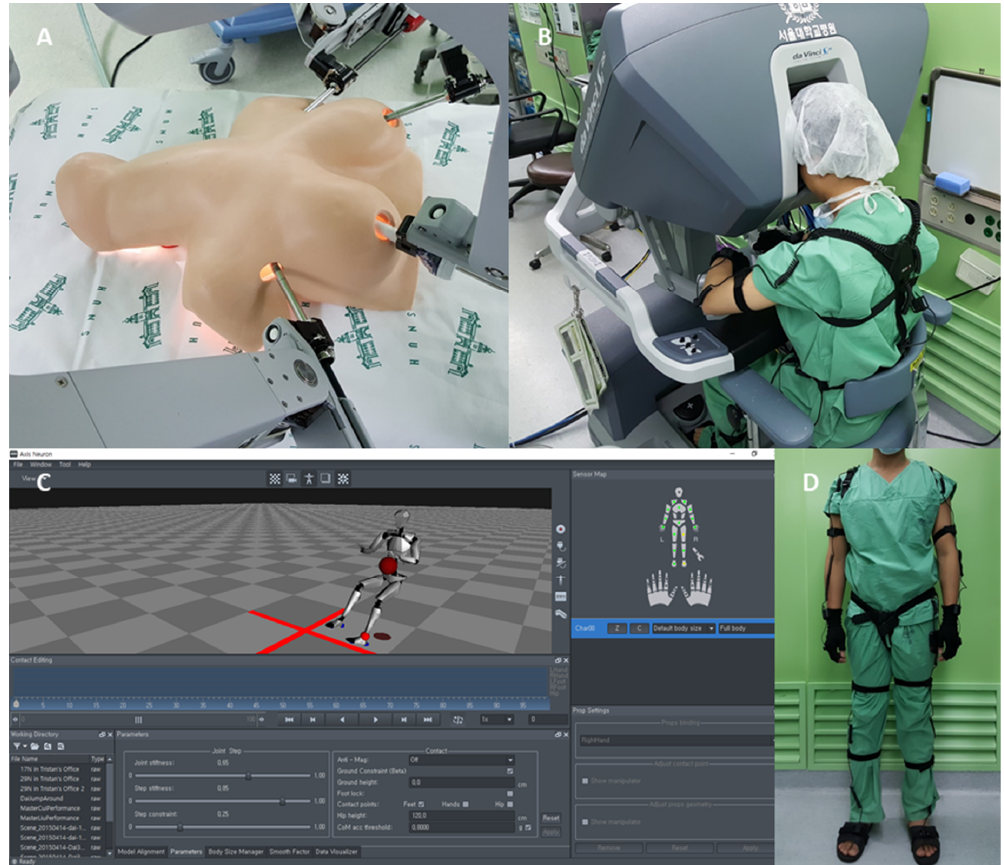
Figure 2. Materials used to study the usefulness of a motion capture device in surgical training. ( A ) Photograph of the BABA training model after the da Vinci robot was docked. ( B ) Photograph of a participant wearing the motion capture device and sitting at the console of the da Vinci robot. ( C ) A screenshot of the software program that was used to acquire motion data information from the Perception Neuron ® device. ( D ) Photograph of a participant wearing the Perception Neuron ® motion capture